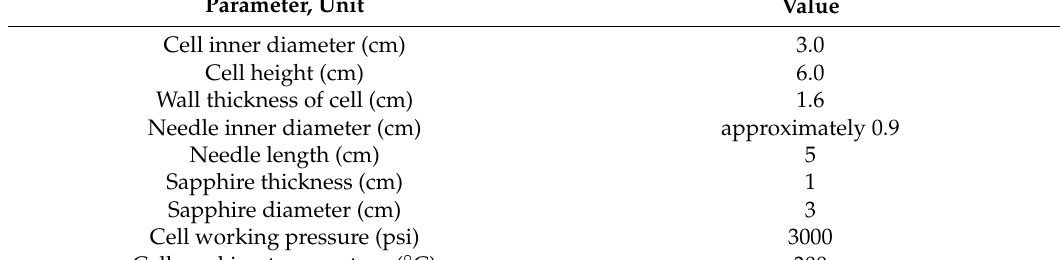
Table 3. Specifications of high pressure and high temperature (HPHT) cell.